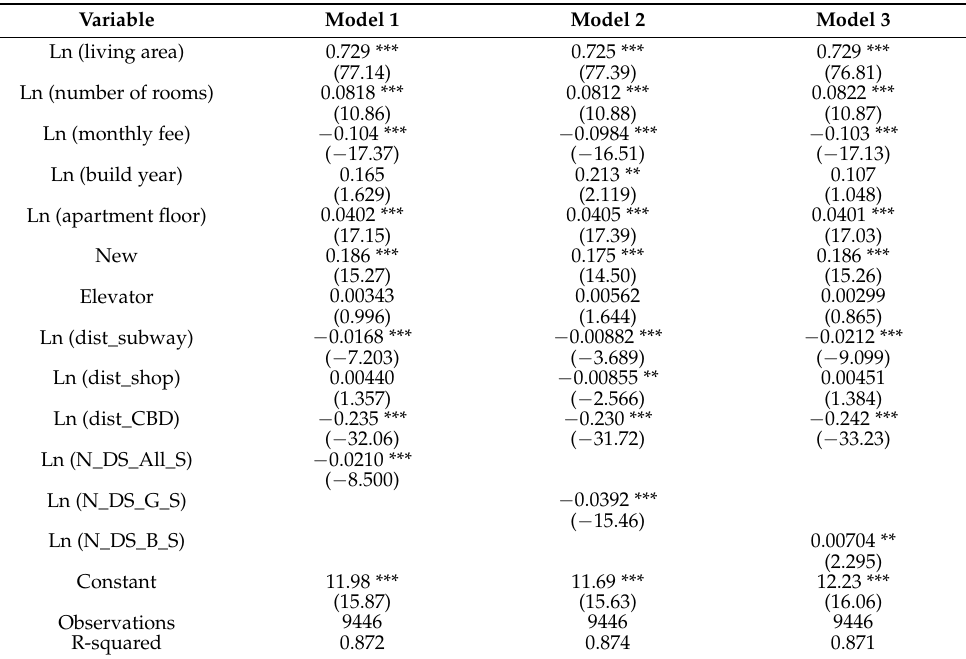
Table A1. HPM results for Measure